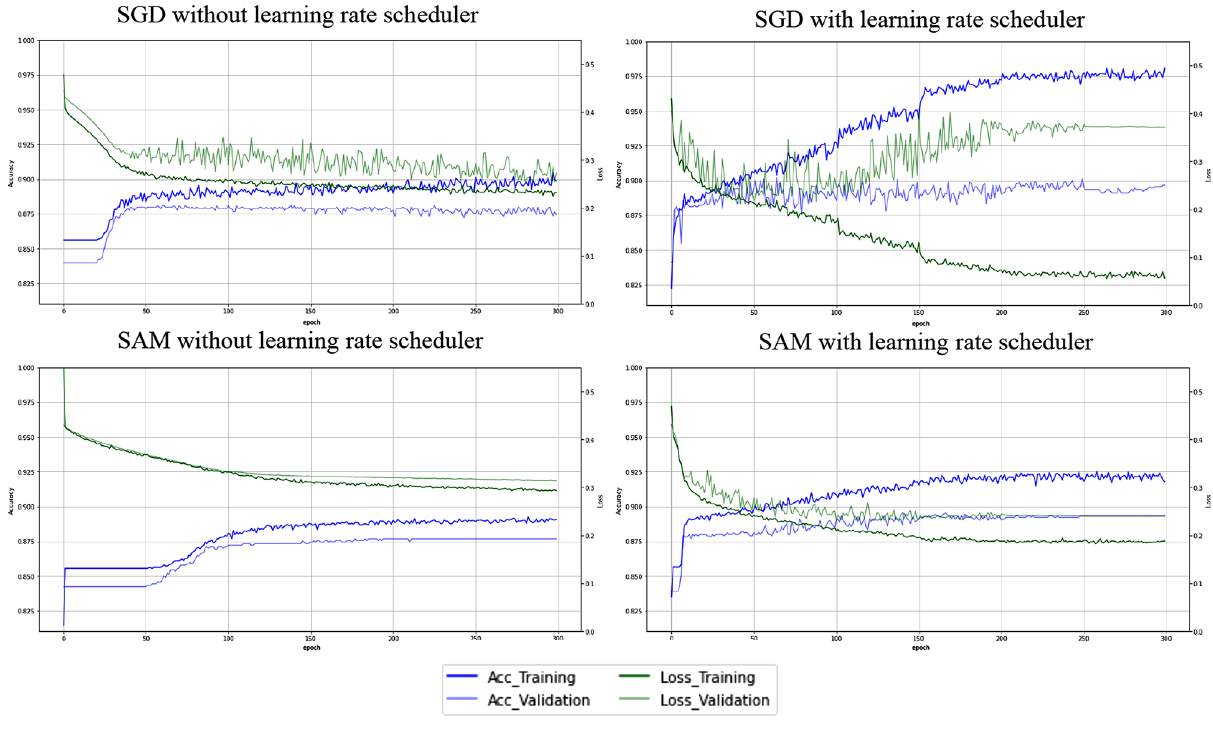
Figure 2. Learning curve in each CNN model.